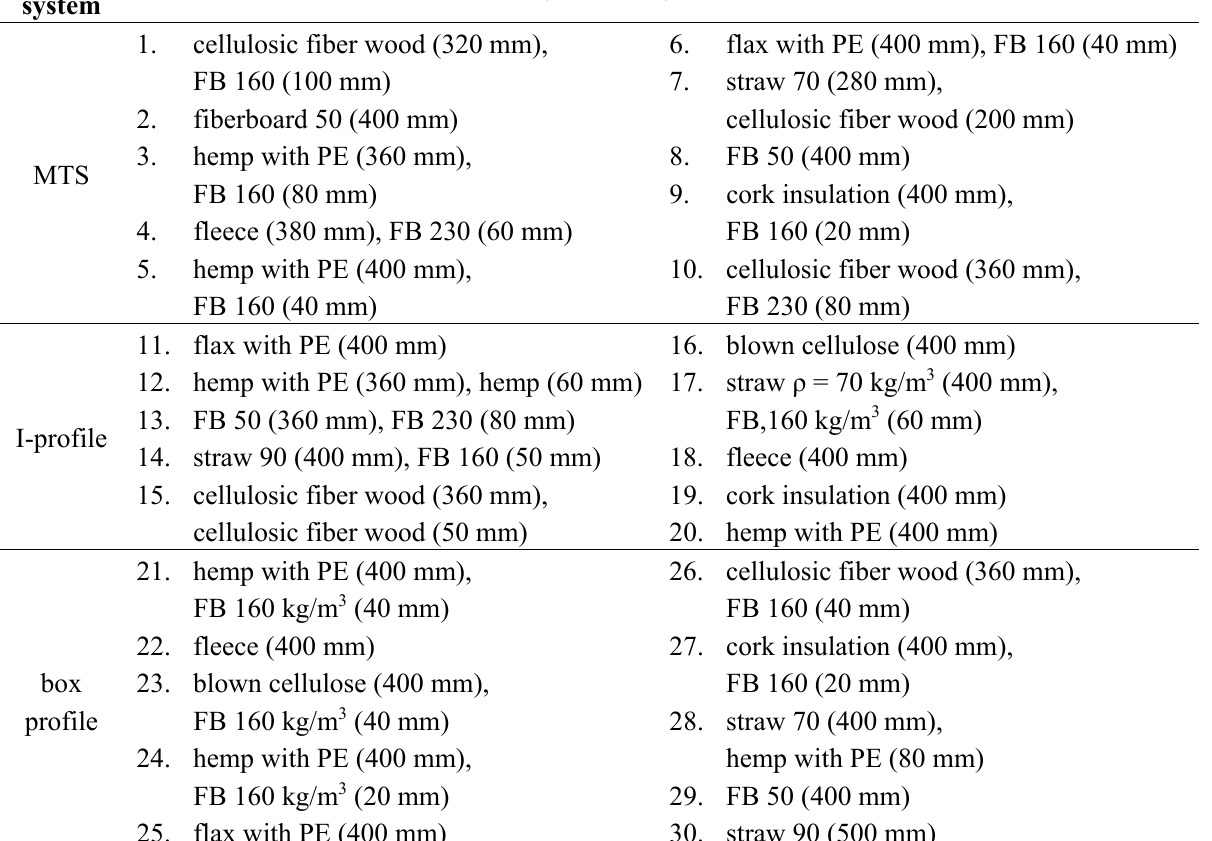
Table 2. Description of above-the-ground floor construction